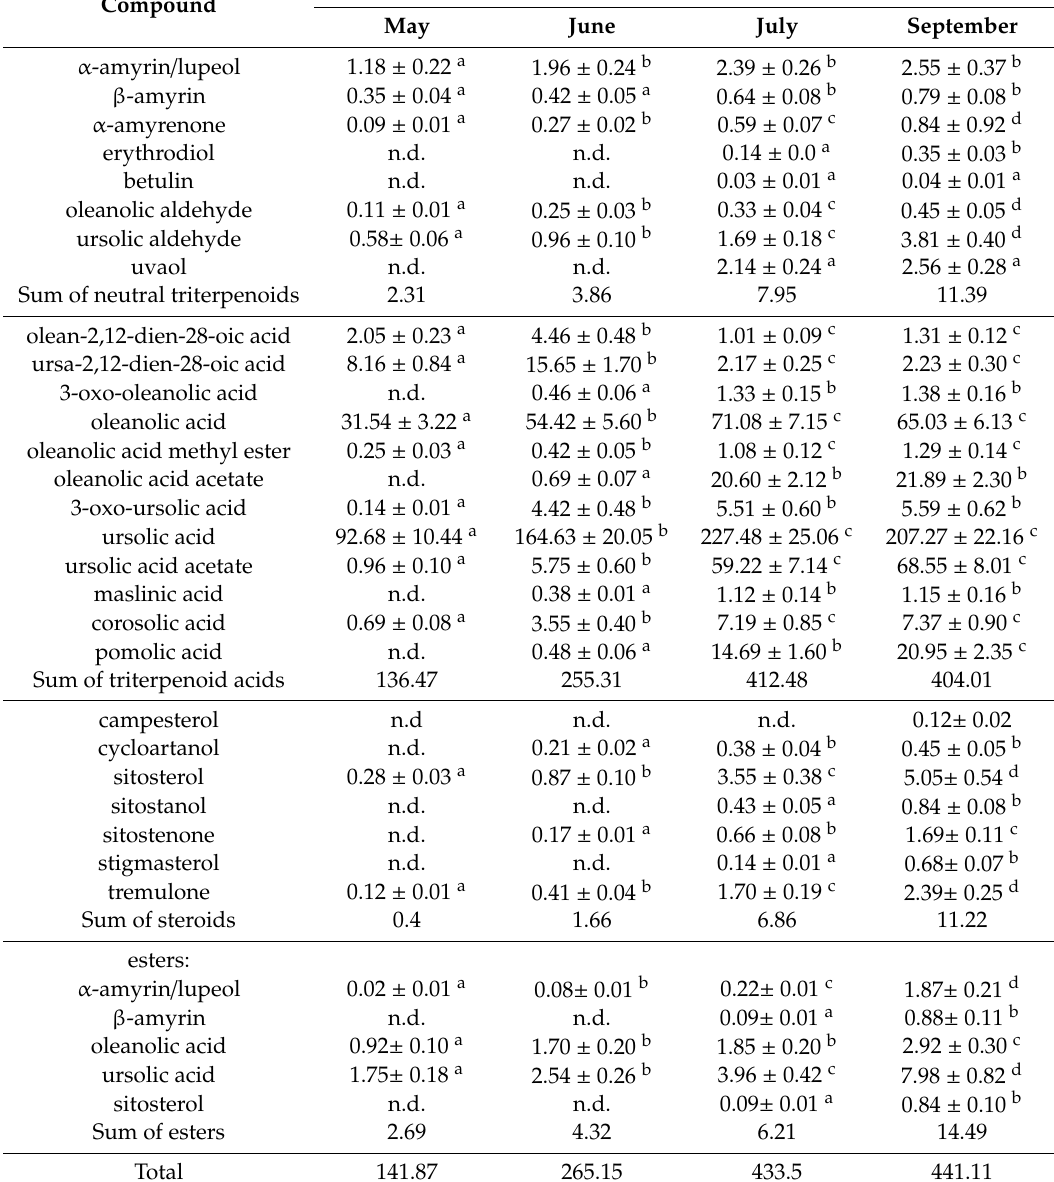
Table 2. Content of triterpenoids in cuticular waxes during black chokeberry ( Aronia melanocarpa ) var. Galicjanka fruit development (very young fruit harvested in May, young fruit in June, fully developed but not ripened fruit in late July and ripened fruit in